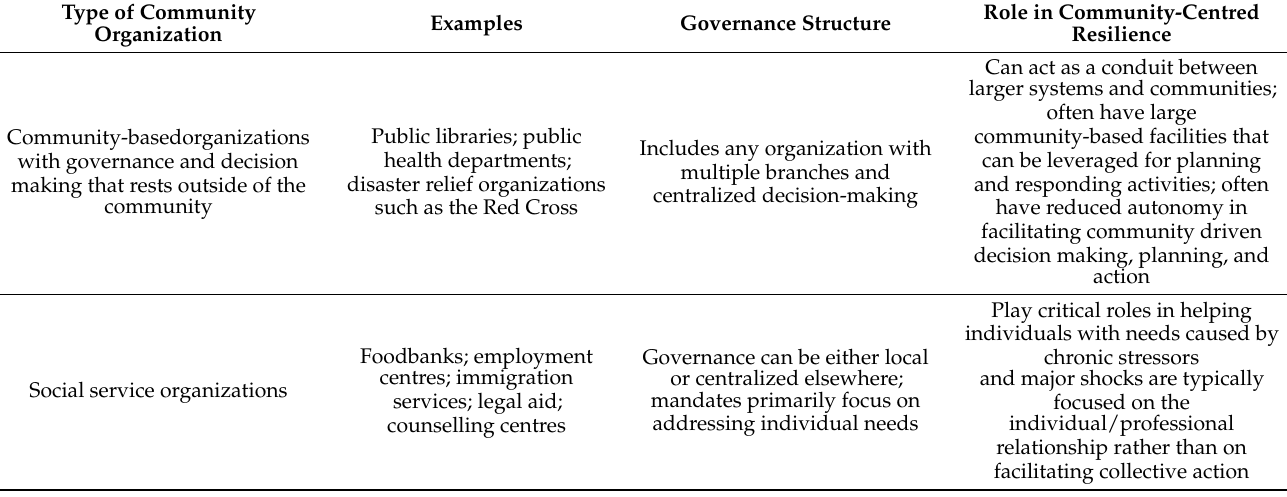
Table 1. A typology of community organizations by structure and role in community-centred resilience [84,108]. Type of Community